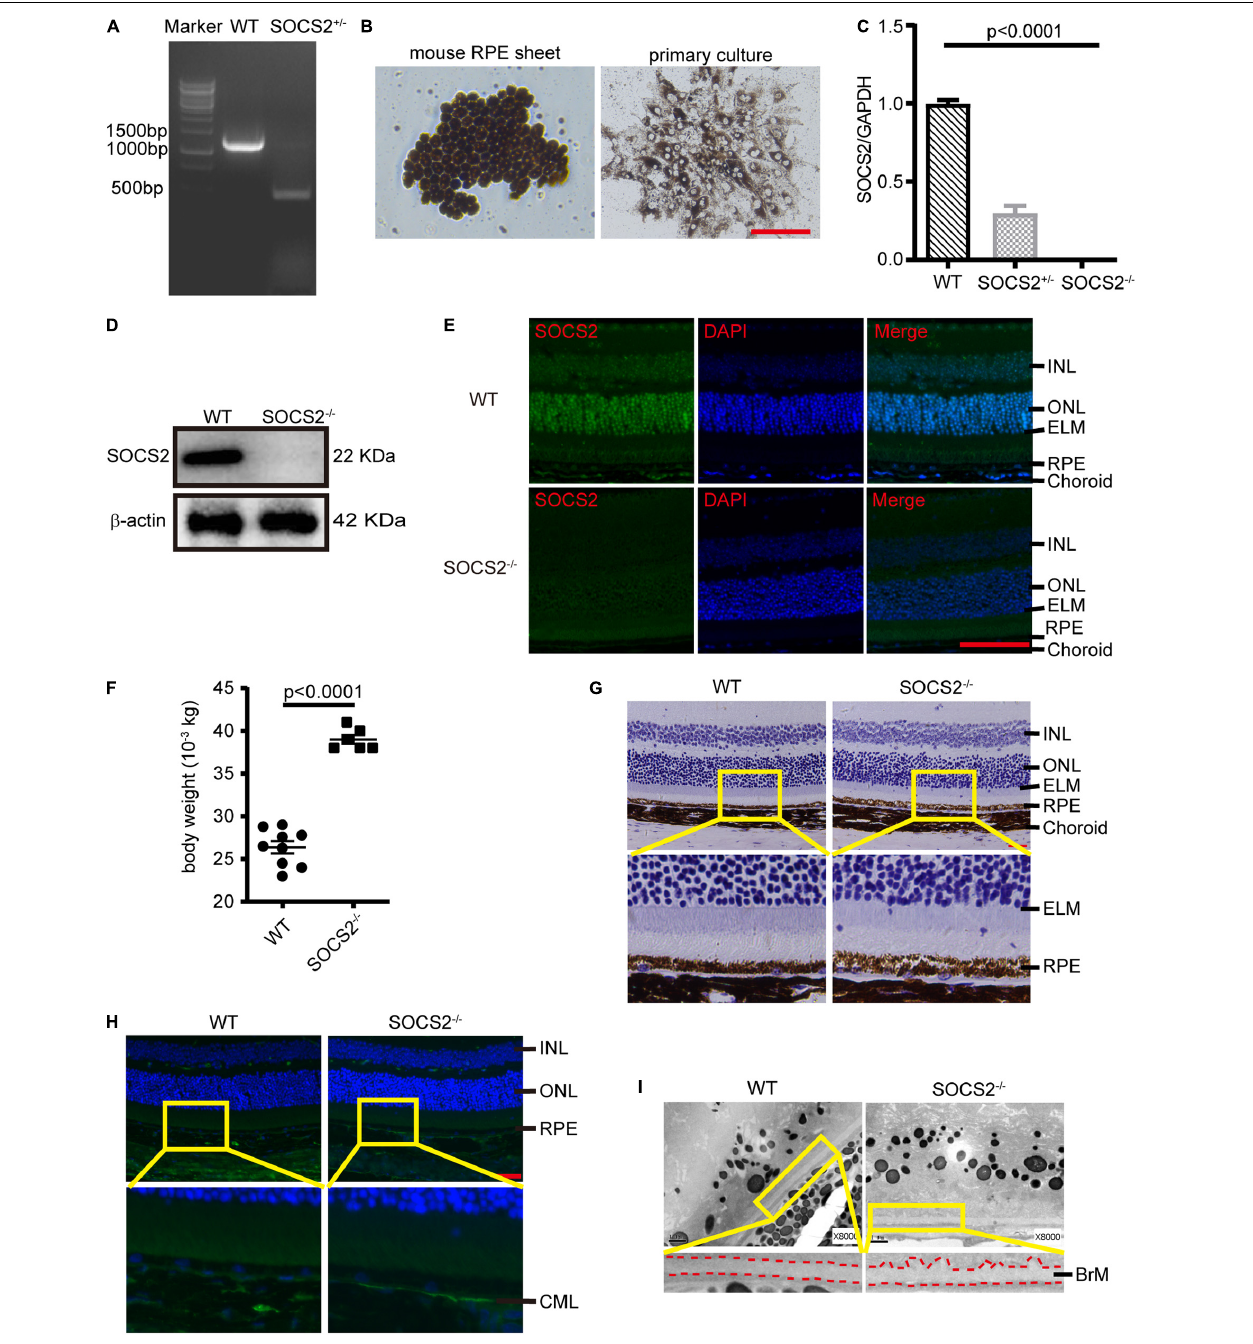
FIGURE 1 | Abnormal RPE-Bruch’s membrane (BrM)-choriocapillaris complex of SOCS2 − / − mice. (A) PCR screening of SOCS2 + / − mice F1 founder to detect SOCS2 sequence from genomic DNA. (B) Primary culture of RPE cells isolated from WT mice. Scale bar, 200 µ m. (C) Real-time quantitative PCR detected the mRNA expression of SOCS2 in the primary RPE of WT, heterozygote, and homozygote. Statistical significance was determined by using the one-way ANOVA. (D) Western blot detected the protein expression of SOCS2 in the RPE of WT and SOCS2 − / − mice. (E) SOCS2 expression and location in the retina of WT and SOCS2 − / − mice. Scale bar, 50 µ m. (F) The body weights of the SOCS2 − / − ( n = 6, 8 weeks old, including males and females) and WT littermates ( n = 9, 10 weeks old, including males and females). (G) The structures of the retinal-RPE-choroid were detected by histology in WT and SOCS2 − / − mice ( n = 6, 1-year old, including males and females). Scale bar, 50 µ m. (H) CML was detected by immunofluorescence on the sections of retinal-RPE-choroid from WT and SOCS2 − / − mice ( n = 6, 1-year old, including males and females). Scale bar, 50 µ m. (I) BrM and deposits were detected by transmission electron micrographs on the sections of retinal-RPE-choroid from WT and SOCS2 − / − mice ( n = 6, 1-year old, including males and females). Scale bar, 1 µ m. Abbreviations: SOCS2, suppressor of cytokine signaling 2; mRNA, messenger RNA; INL, inner nuclear layer; ONL, outer nuclear layer; ELM, external limiting membrane; RPE, retinal pigment epithelium; WT, wild type.